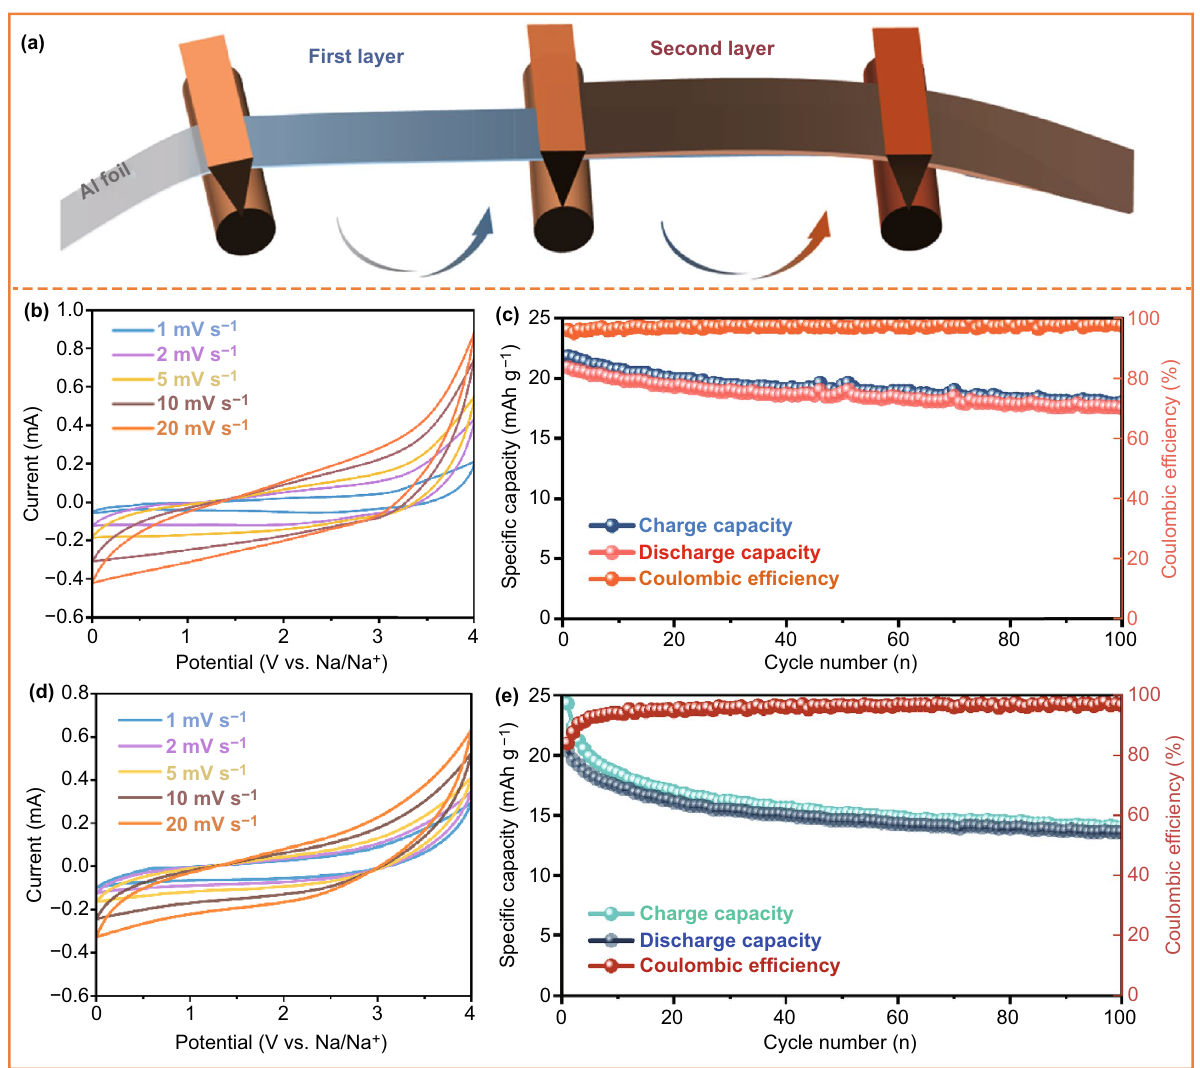
Fig. 4 a Schematic illustration of double coating strategy. b CV curves of TiO 2 //AC-NCO-S-3D-15% at different scan rates after activation. c Cycling performance and CE of TiO 2 //AC-NCO-S-3D-15% under 1 C at 4–0 V after pre-sodiation. d CV curves of TiO 2 //AC-NCO-SP-15% at various scan rates after activation. e Cycling performance and CE of TiO 2 //AC-NCO-SP-15% under 1 C at 4–0 V after